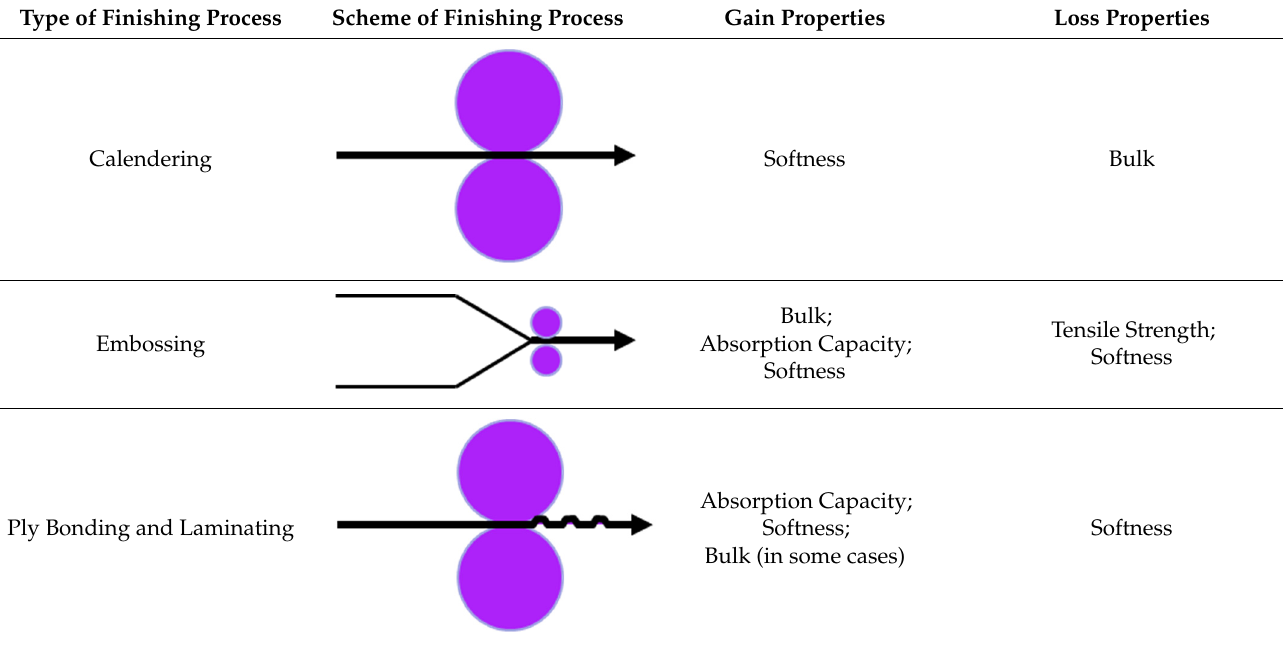
Table 2. Main effects of finishing processes on paper properties [11]. Type of Finishing